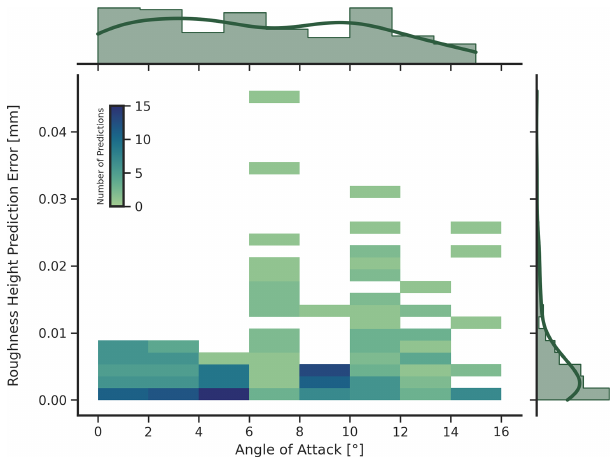
Figure 14. Error in the prediction of equivalent sand grain rough- ness height as a function of the angle of attack gathered on the val- idation dataset. The x -axis histogram gives an indication of how the angle of attack is distributed over the validation set. Prediction quality appears to decrease for higher angles of attack; neverthe- less most of the prediction errors are distributed below 0.01mm, as highlighted by the y -axis